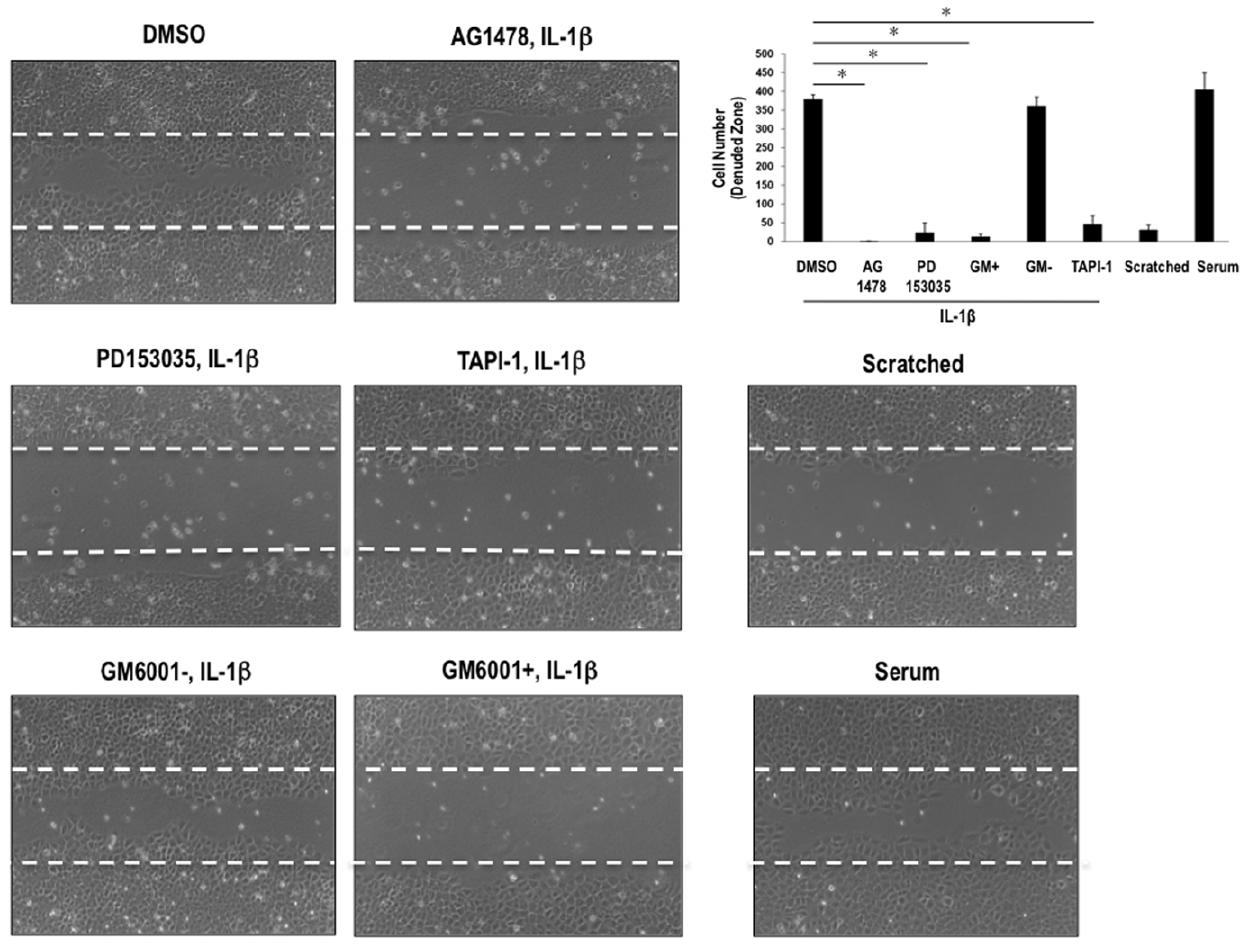
Figure 5. MMP and EGFR inhibitors block SMC wound repair. Growth-quiescent SMCs were incubated with GM6001 + or GM6001- (25 m M), TAPI-1 (10 m M), AG1478 (5 m M), PD153035 (5 m M) or vehicle for 30 min followed by in vitro scraping injury and addition of IL-1beta (10 ng/ml). Photographs of the denuded zone were taken at 24 h.